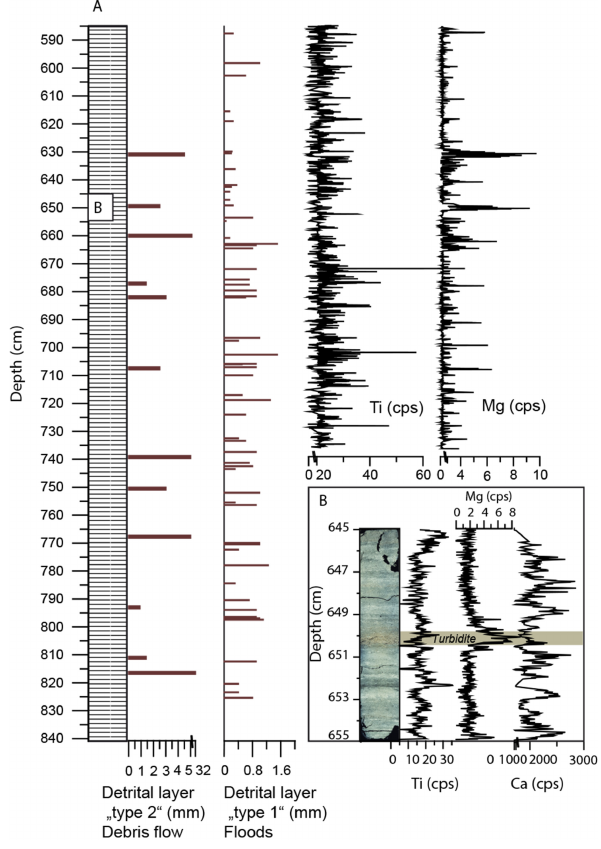
Fig. 4. Sediment data. (a) Lithology of the sediment core covering the interval between 585 and 840cm with complementing detrital layer record (for further explanations see the main text), results of magnetic susceptibility measurements and µXRF element scanning data for titanium (Ti) and magnesium (Mg) for the interval between 585 and 736cm. (b) Sediment microfacies as revealed from a thin section (645–655cm) with a turbidite (detrital layer type 1) and cor- responding µXRF data for Ti, Mg and Ca.